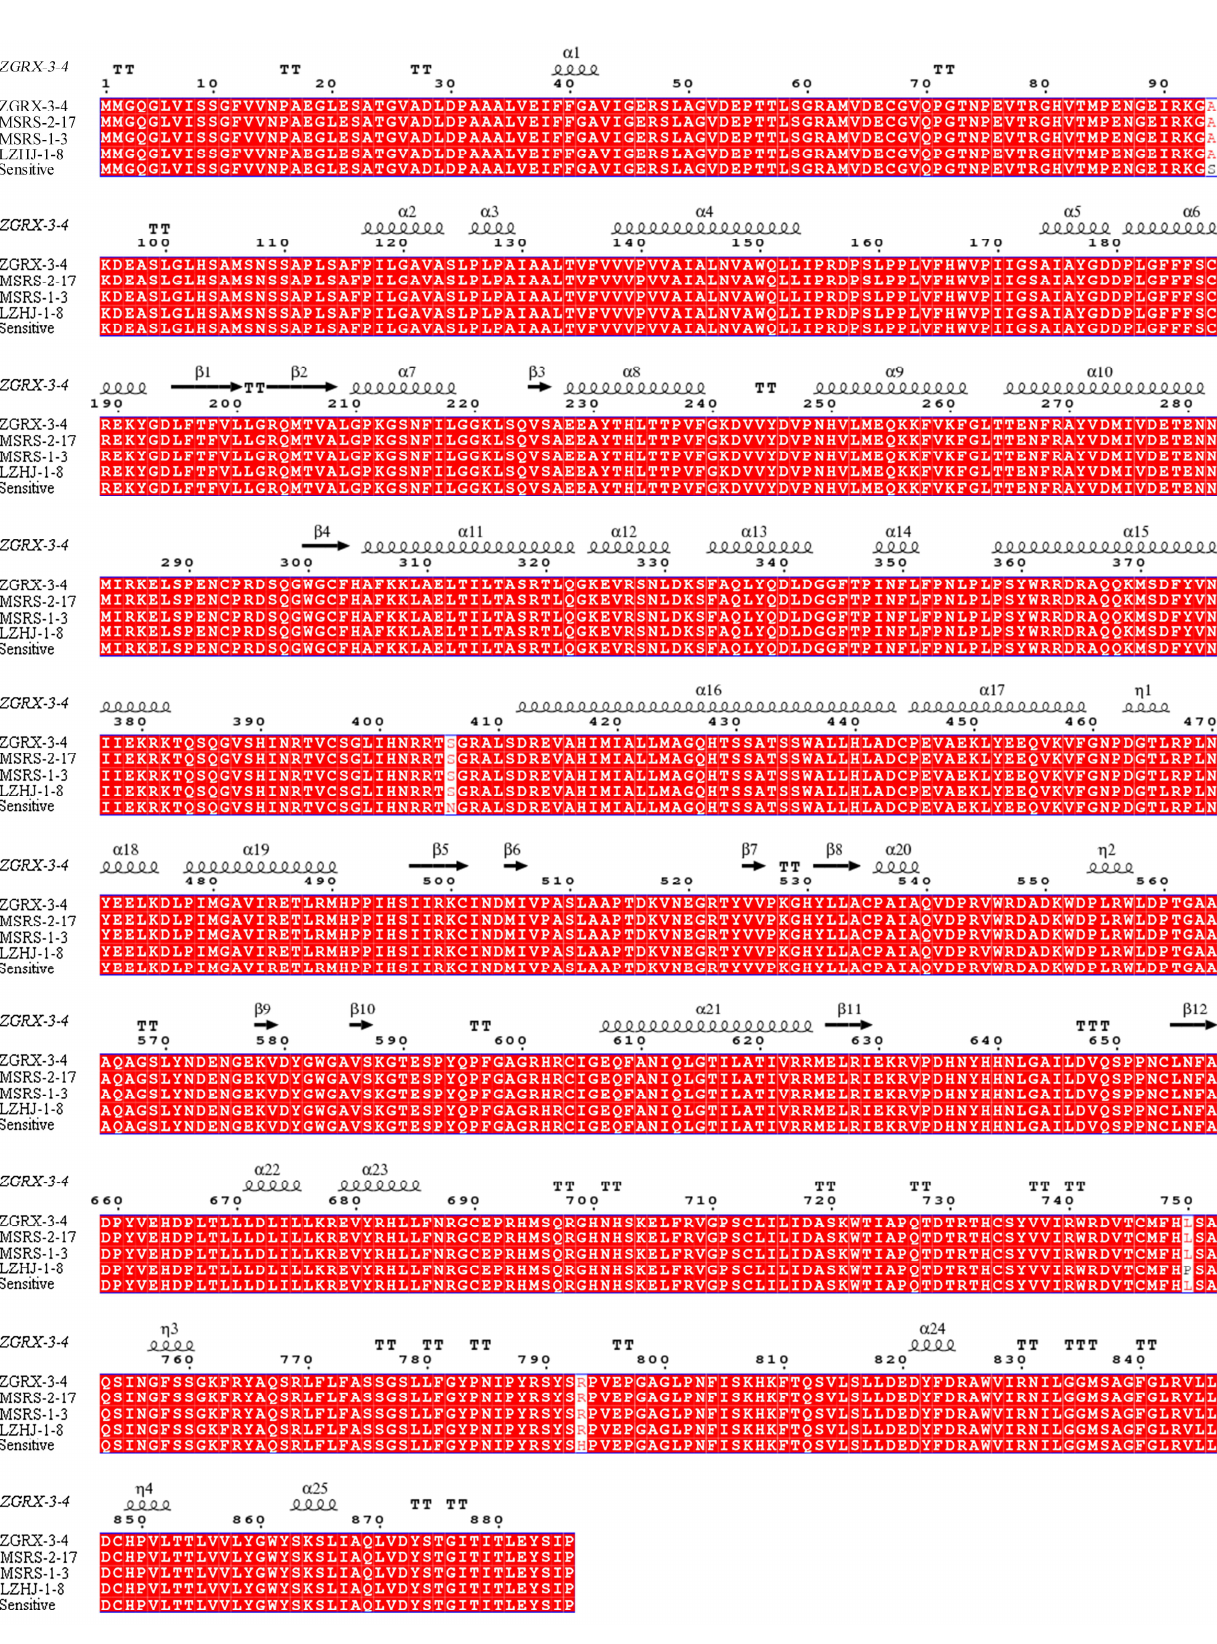
Figure 5. Sequence alignment of amino acid of CYP51 in different isolates.